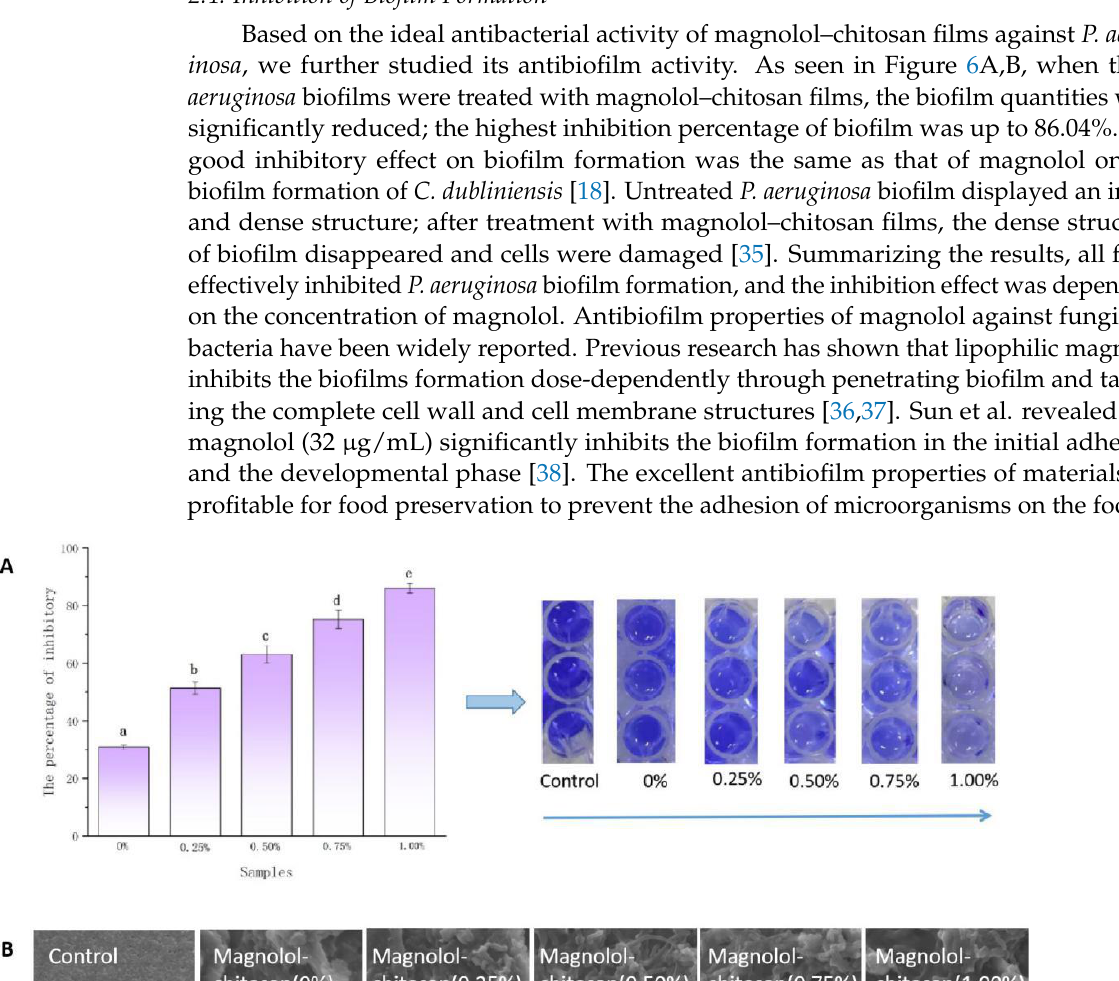
( C ) Figure 7. The pH values ( A ), TVC ( B ) and sensory evaluation ( C ) of pork samples during storage at 4 °C for 6 days. Notes: 0%, magnolol–chitosan film without magnolol. 0.25%, magnolol–chitosan film with 0.25% of magnolol. 0.50%, magnolol–